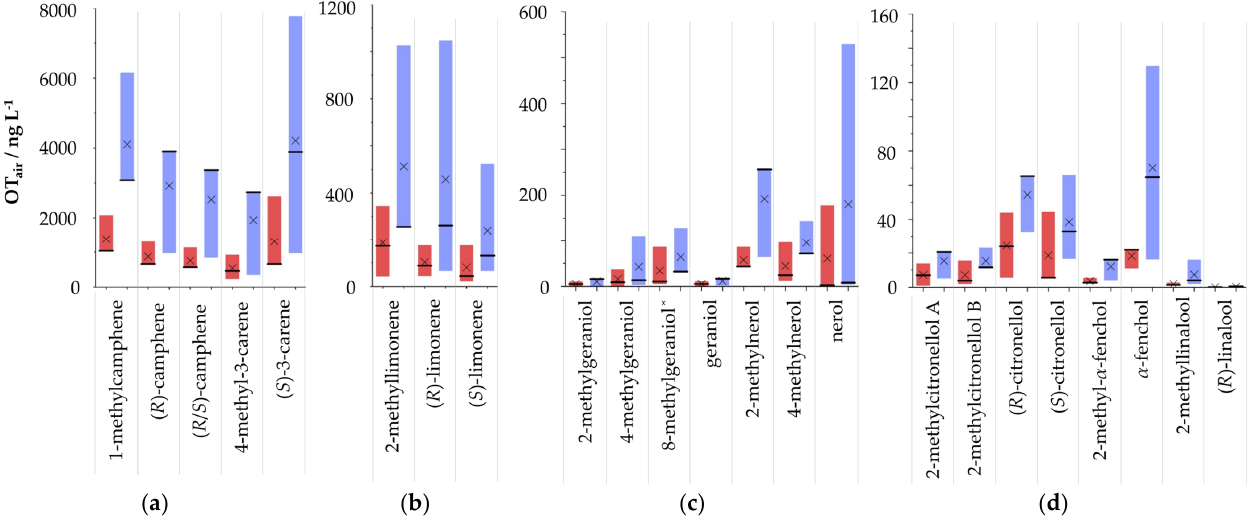
Figure 4. Ranges of the odor thresholds in the air from the three participants with the averages marked with a cross and the median labeled with a line for methylated and non-methylated compounds ( a ) camphene and carene derivatives; ( b ) limonene derivatives; ( c ) geraniol derivatives; ( d ) citronellol, fenchol, and linalool derivatives, according to Teranishi et al. in blue and the threshold determined with the individual determined threshold of (2 E )-decenal in red, x = mixture of ( E ) and ( Z ) isomers.